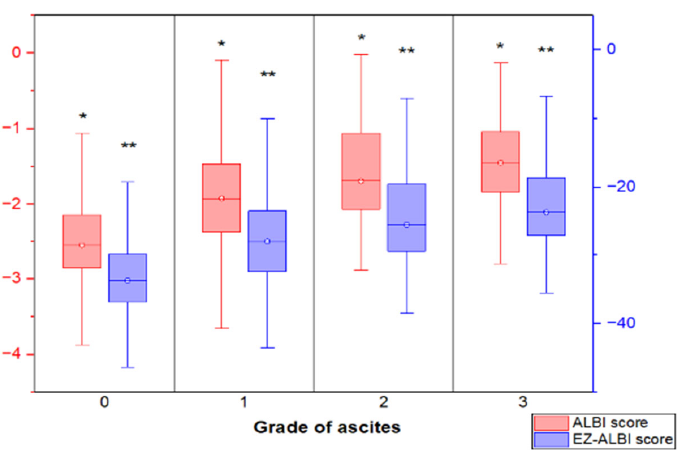
Figure 1. The box plot showing the distribution of ALBI score and EZ-ALBI score in HCC patients with different grades of ascites and without ascites. Patients with higher grade of ascites had both higher ALBI and EZ-ALBI scores ( p < 0.001). The interquartile range (box), median (horizontal line), and range (vertical lines) values were presented with box-and-whisker plot of the ALBI score and EZ-ALBI score. * p < 0.001, ** p < 0.001.